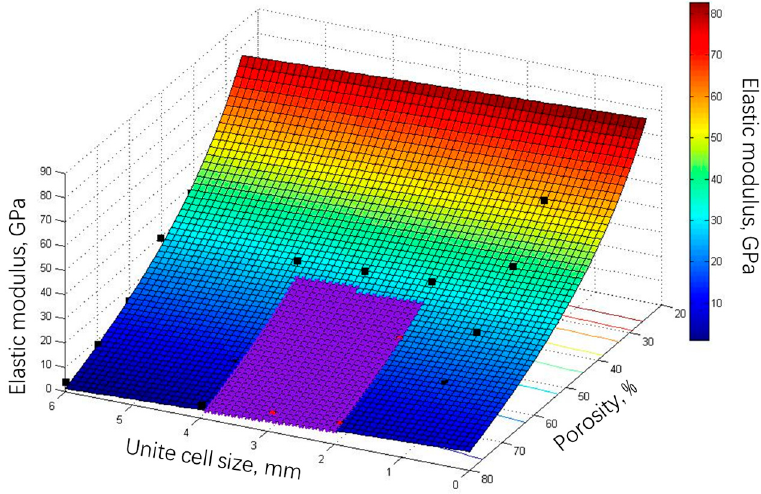
Figure 14. Three-dimensional fitting surface basis on the correlation among unit cell size, porosity and dynamic elastic modulus.